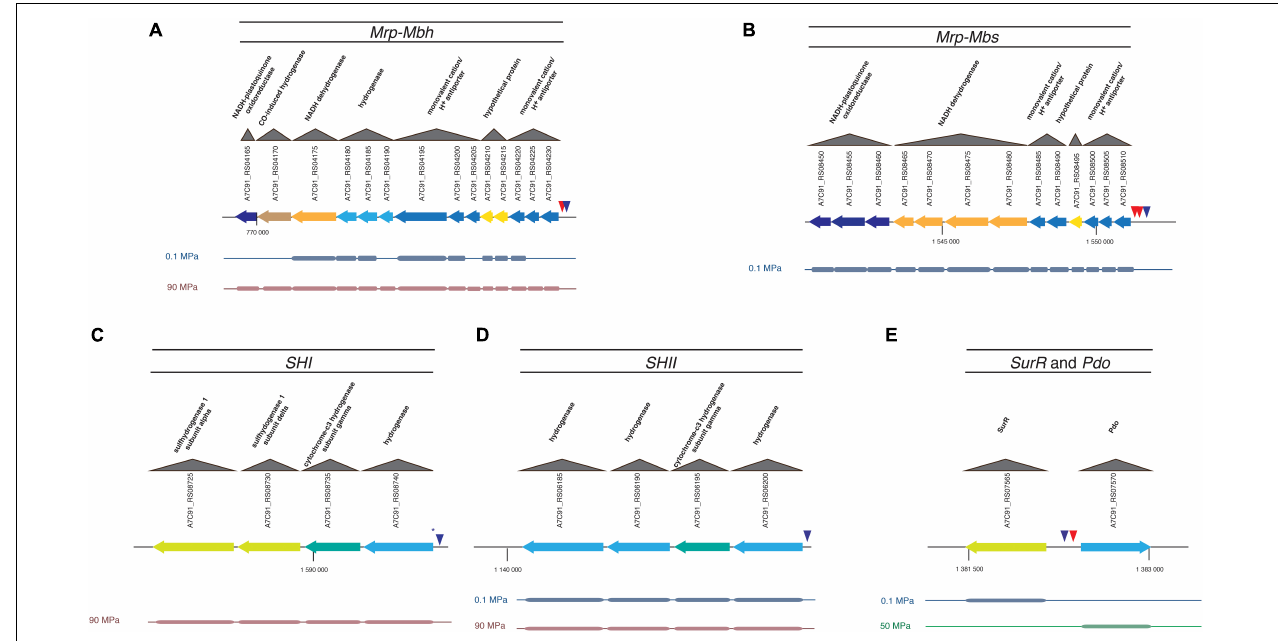
FIGURE 2 | MBH, MBS, SHI, SHII, and SurR gene clusters regulated in hydrogenogenic/sulfidogenic metabolisms and their SurR binding motifs. (A) Mrp-Mbh ; (B) Mrp-Mbs ; (C) SHI ; (D) SHII ; (E) SurR and Pdo . Each gene is colored according to its differential expression condition (0.1 MPa in blue, 50 MPa in green, or 90 MPa in red). Triangles represent the SurR binding motifs. Red triangle is for the short binding motif (GTT n 3 AAC) and blue triangle is for the long one (GTT n 3 AAC n 5 GTT). The asterisk means that the motif carries a mutation. The other gene clusters regulated in hydrogenogenic/sulfidogenic metabolisms are shown in